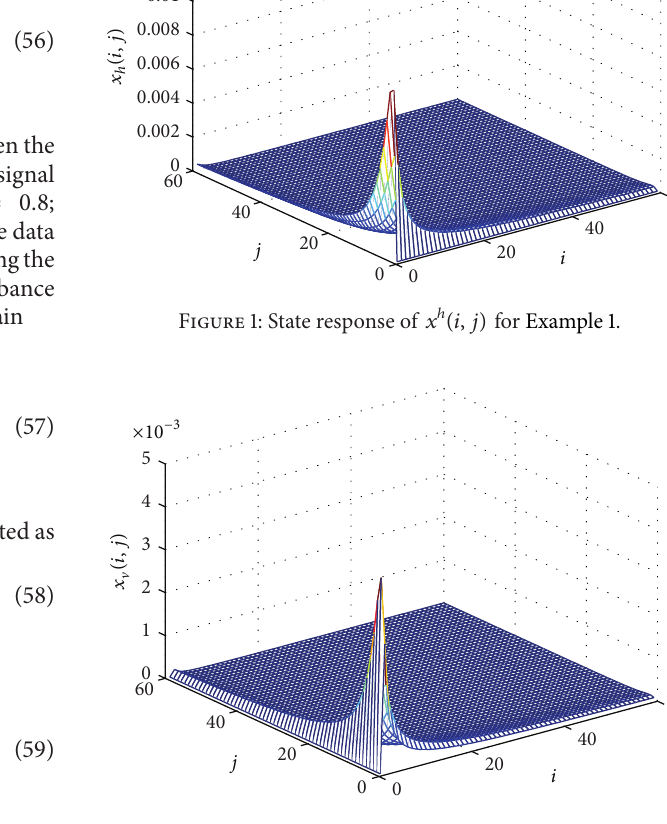
Figure 2: State response of 𝑥 V (𝑖,𝑗) for Example